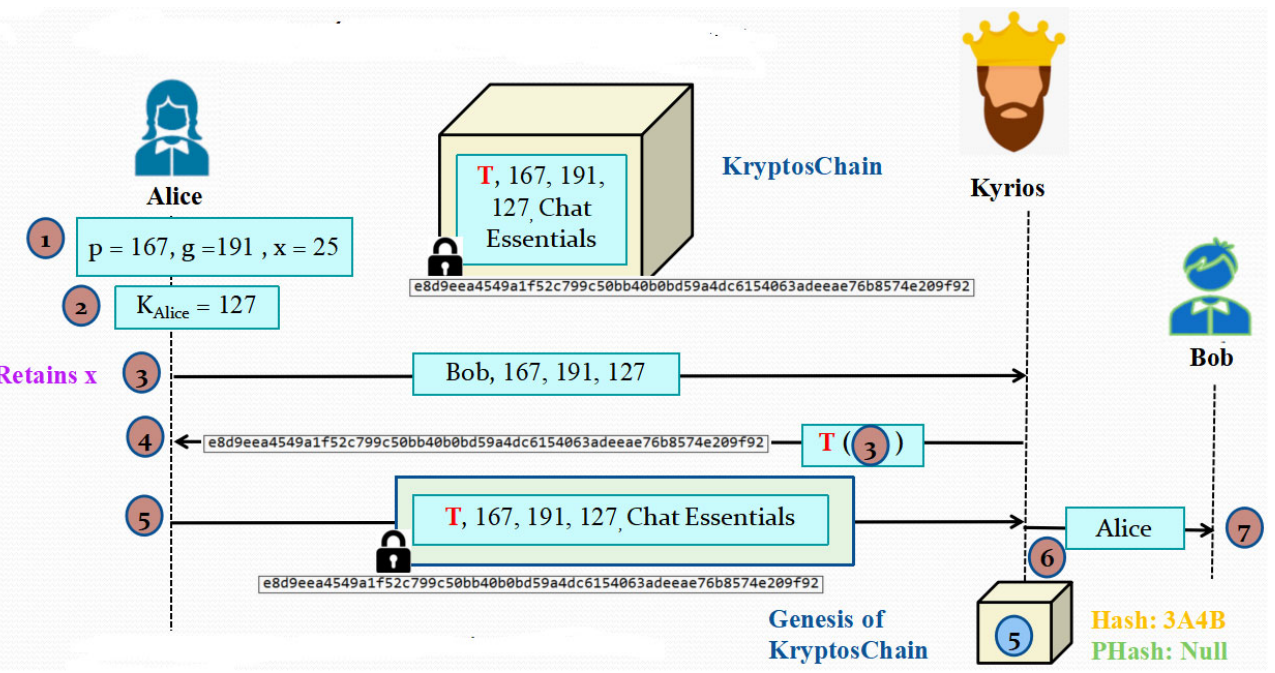
Figure 12. Demonstration of Phase 2: Sender Authentication.